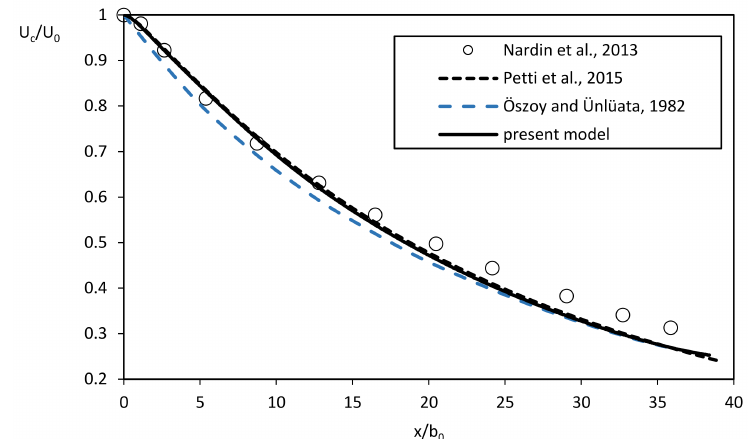
Figure 3. Longitudinal velocity U c , taken along the jet centerline, normalized with the velocity at the jet inlet, U 0 . In the abscissa, x is the distance from the start of the zone of established flow (ZOEF) normalized with the half-width of the inlet, b 0 .